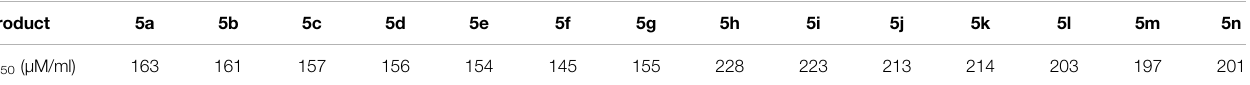
TABLE 5 | IC 50 value of pyrazolopyranopyrimidine derivatives in anticancer activity.